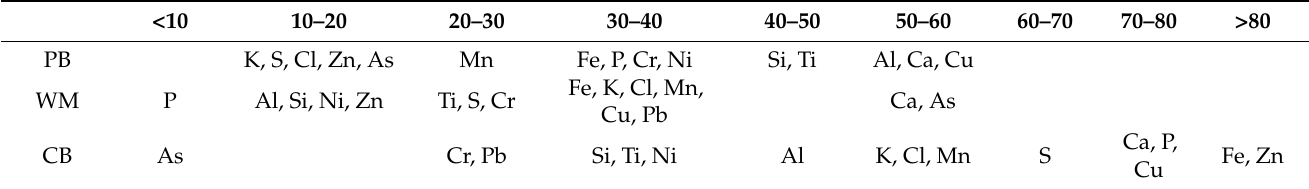
Table 8. Amounts of elements contained in ash (%)—calculated from mass